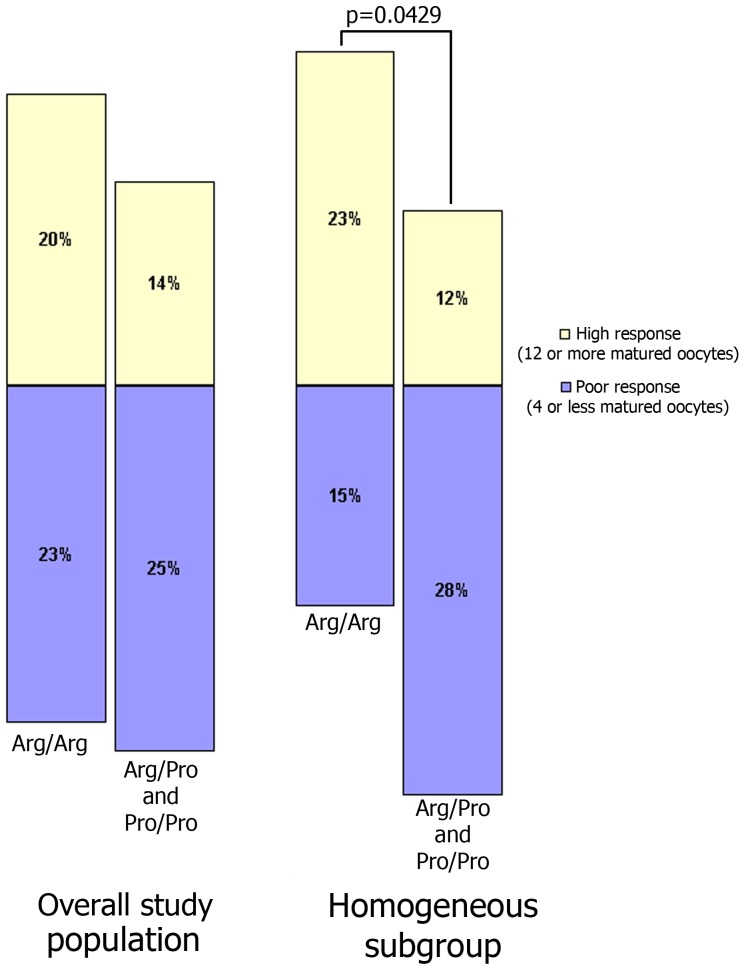
Poor and high response risks, according to p5372 polymorphism genotypes.